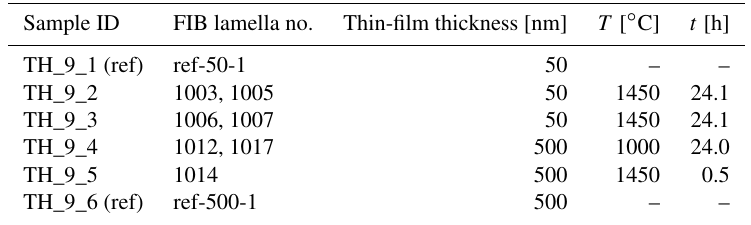
Table 1. Experimental conditions, sample IDs, and corresponding FIB lamella numbers. Sample